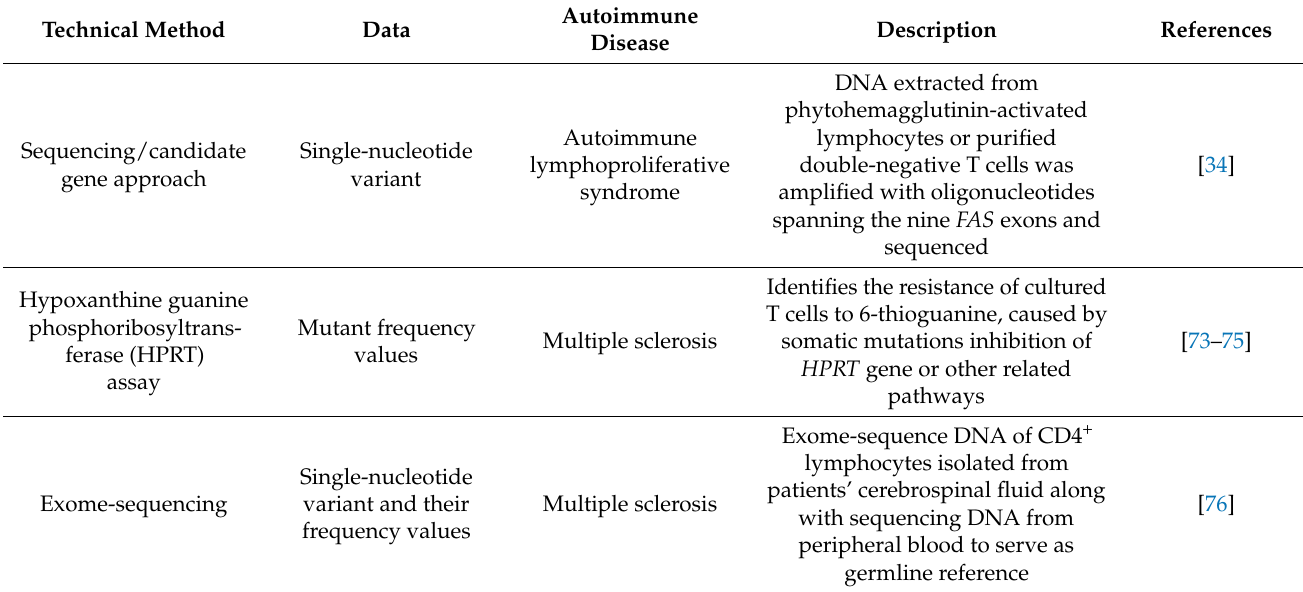
Table 1. Technical approaches for detecting somatic mutations in